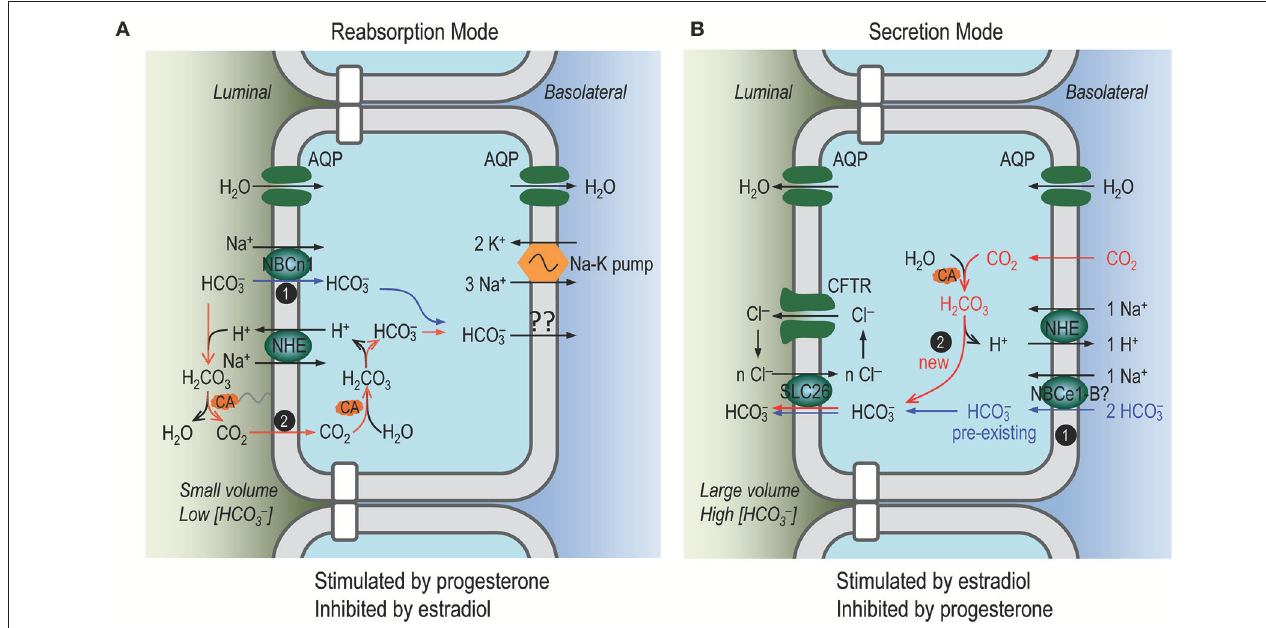
FIGURE 9 | Proposed model for reabsorption and secretion of HCO − 3 in endometrial epithelium. (A) Secretion of HCO − 3 by the endometrial epithelium. (B) Reabsorption of HCO − 3 by the endometrial epithelium. In the reabsorption mode, the endometrial epithelium would perform net fluid reabsorption, whereas in the secretion mode, the endometrial epithelium would perform net fluid secretion, via members of aquaporins, such as AQP2, AQP3, AQP5 expressed at the apical and/or basolateral membranes of the endometrial epithelium (Mobasheri et al., 2005; Hildenbrand et al., 2006; Skowronski, 2010; for review, see Zhu et al., 2015). Our expression data and in vivo perfusion data indicate that the activities for HCO − 3 reabsorption and secretion are present at the same time in the endometrial epithelium. We propose that the activity for secretion is dominant during estrus stage when the uterine fluid volume is large and [HCO − 3 ] is high, whereas the activity for reabsorption is dominant during diestrus stage when the uterine fluid volume is small and [HCO − 3 ] is